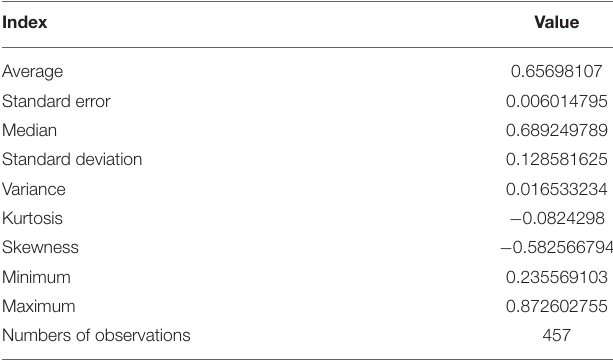
TABLE 4 | Dynamic condition correlation statistical